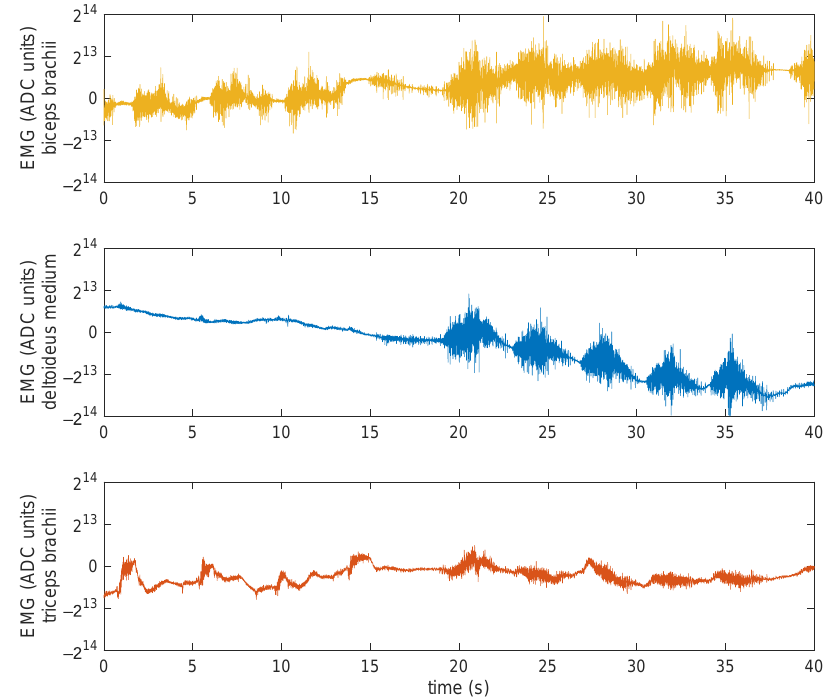
Figure 1. Example of a 3-channel EMG signal recorded from different muscles ( biceps brachii , deltoideus medium , triceps brachii ) on the upper arm while doing a couple of different exercises as detailed in [10]. The units in the vertical axes are just the output ADC count, after offset removal (the offsets for the three muscles were respectively − 12398, − 8725, and + 11999 ADC units). In the deltoideus medium the baseline wander still accounts for most of the signal